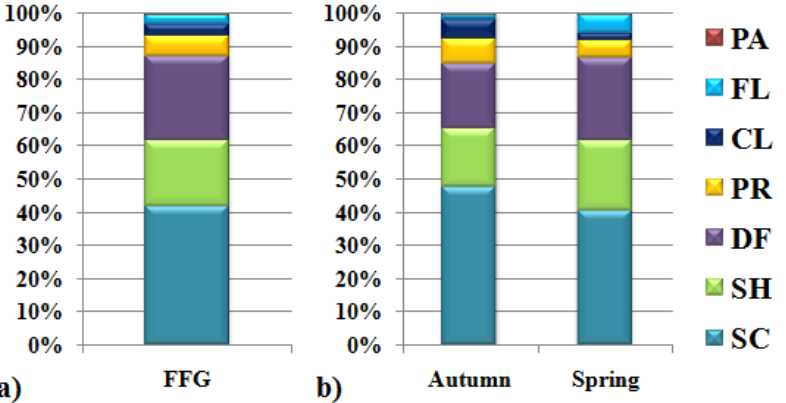
Figure 2. Relative abundance of the FFGs (in %): ( a ) for the whole survey period; ( b ) per sampling season. Legend: x-axis, FFG composition ( a ) and FFG composition per sampled season ( b ); y-axis, relative abundance of the trophic groups (For trophic groups abbreviations, see Materials and Methods).